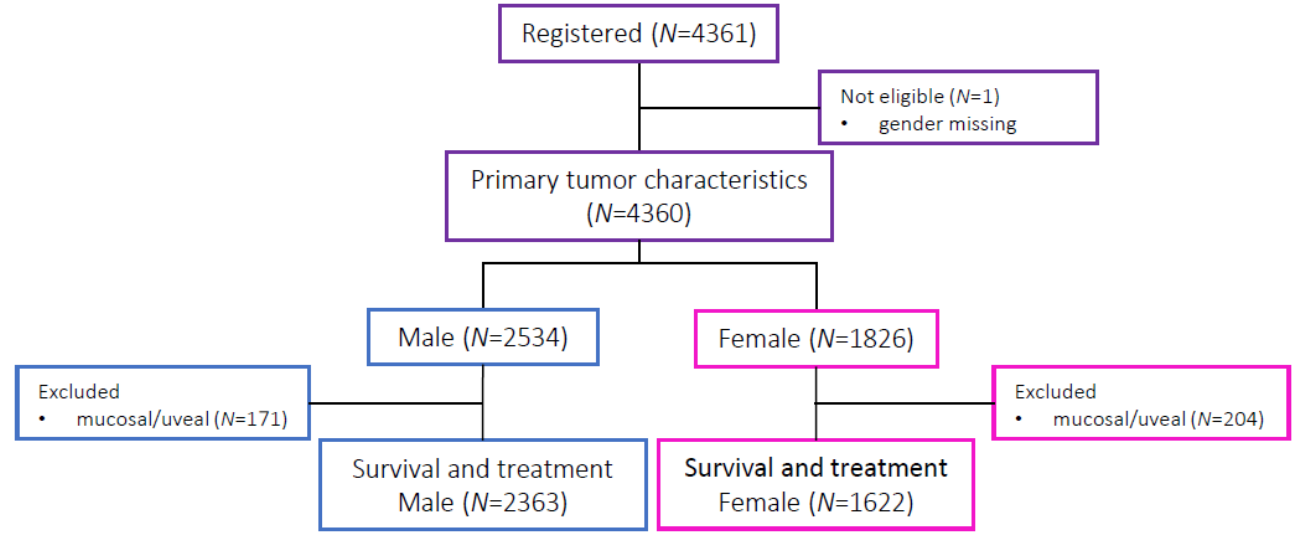
Figure 1. Patient selection for statistical analysis.